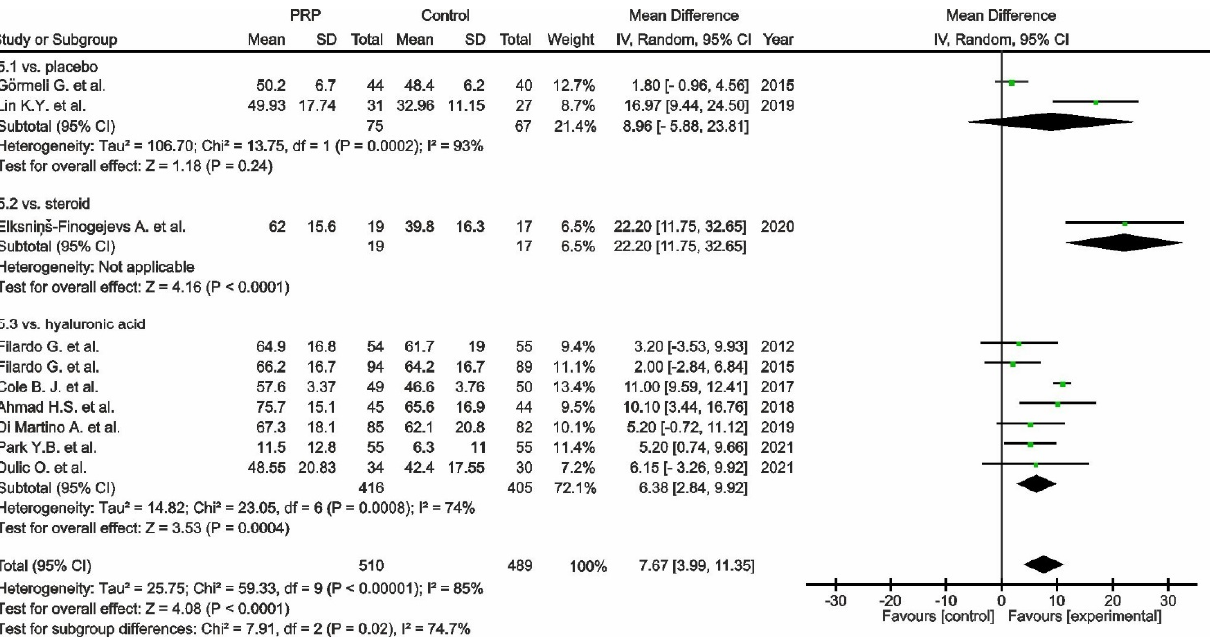
Figure 5. Forest plot for IKDC scores (CI, confidence interval; IV, inverse variance; SD, standard deviation; , mean with 95% confidence interval for total and subtotals; , mean with 95% con- fidence interval for source data ).